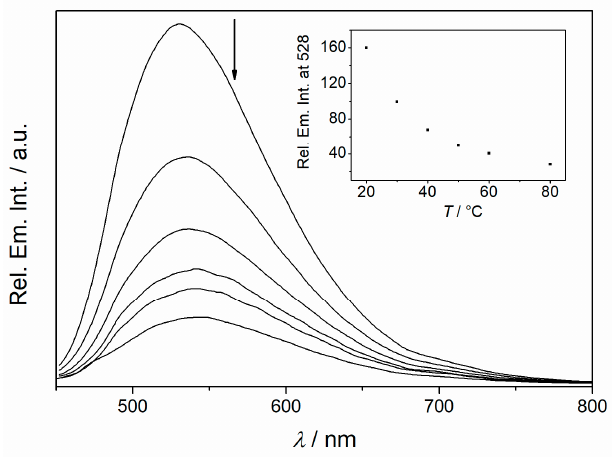
Figure 1. Emission spectra of 2 ( c = 10 µM, with 0.25% v / v DMSO) in glycerol at 20 °C, 30 °C, 40 °C, 50 °C, 60 °C, and 80 °C; λ ex = 430 nm. The arrows indicate the changes in the emission intensity with increasing temperature. Inset: Plot of the relative emission intensity at 528 nm versus the temperature of the solution.